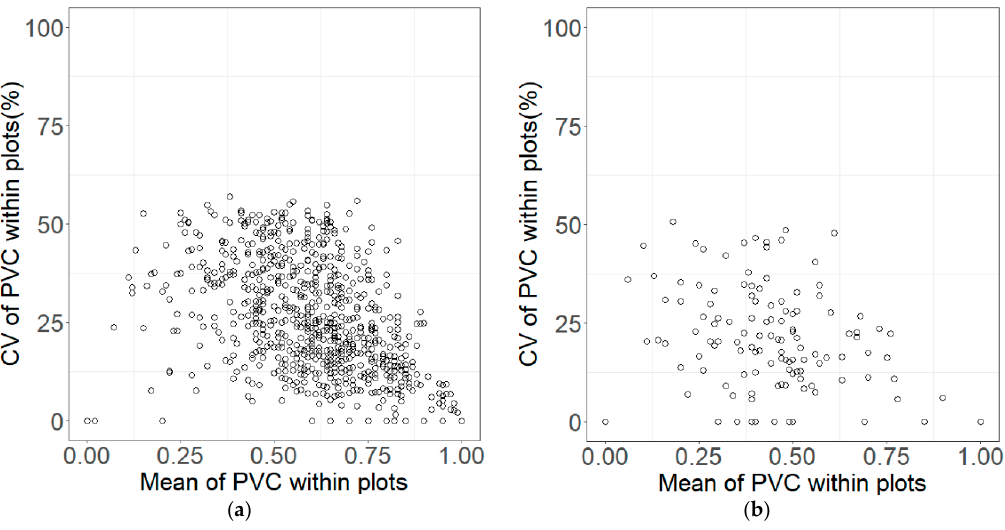
Figure 14. The coefficient of variation (CV) of the PVC observations from five 1 m × 1m subplots within each of the plots graphed against their mean for ( a ) Duolun and ( b ) Kangbao County.